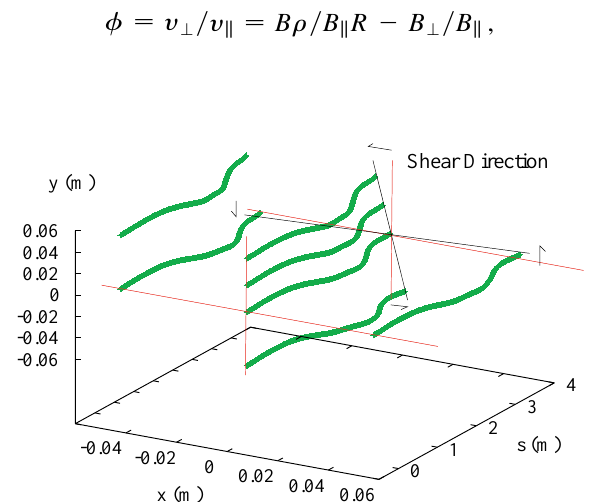
FIG. 12. (Color) Tracking through a bend in three dimensions with tipped and turned coils. The tracks show shear from perpendicular field components which is more clearly seen in Fig.